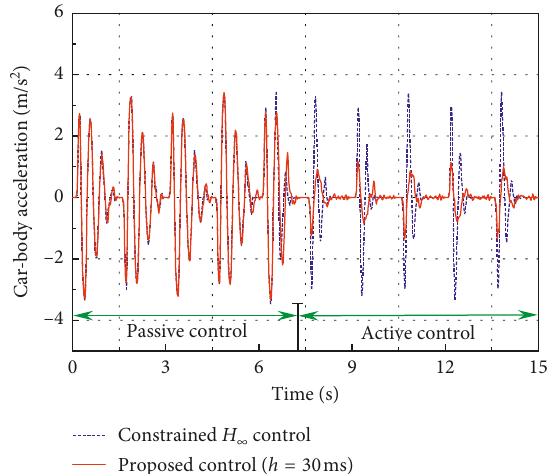
Figure 14: Hardware results of suspension displacement under sinusoidal wave